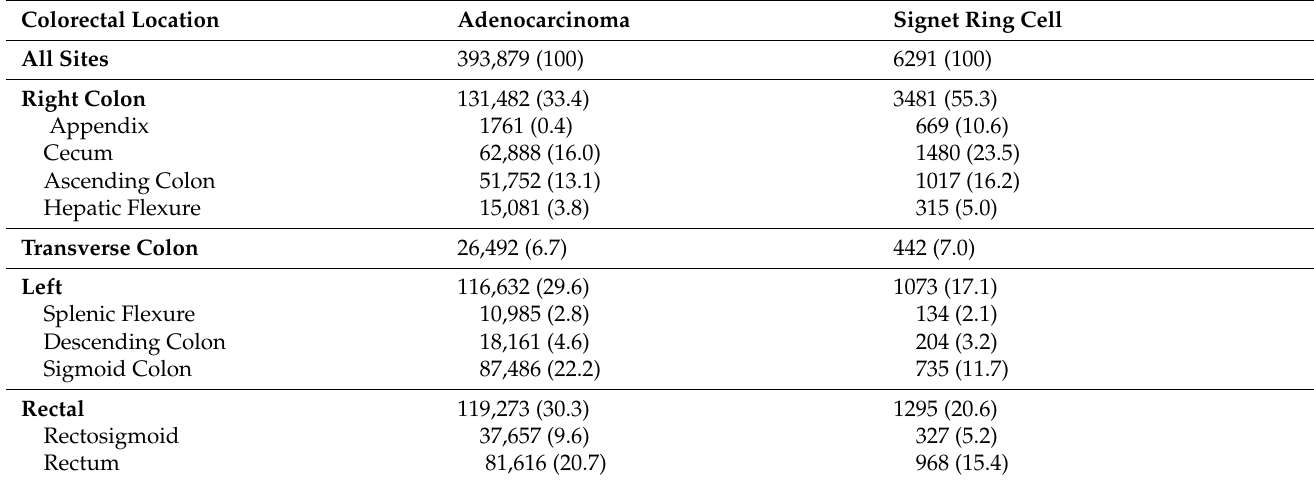
Table 4. Distribution of colorectal cancer by localization.